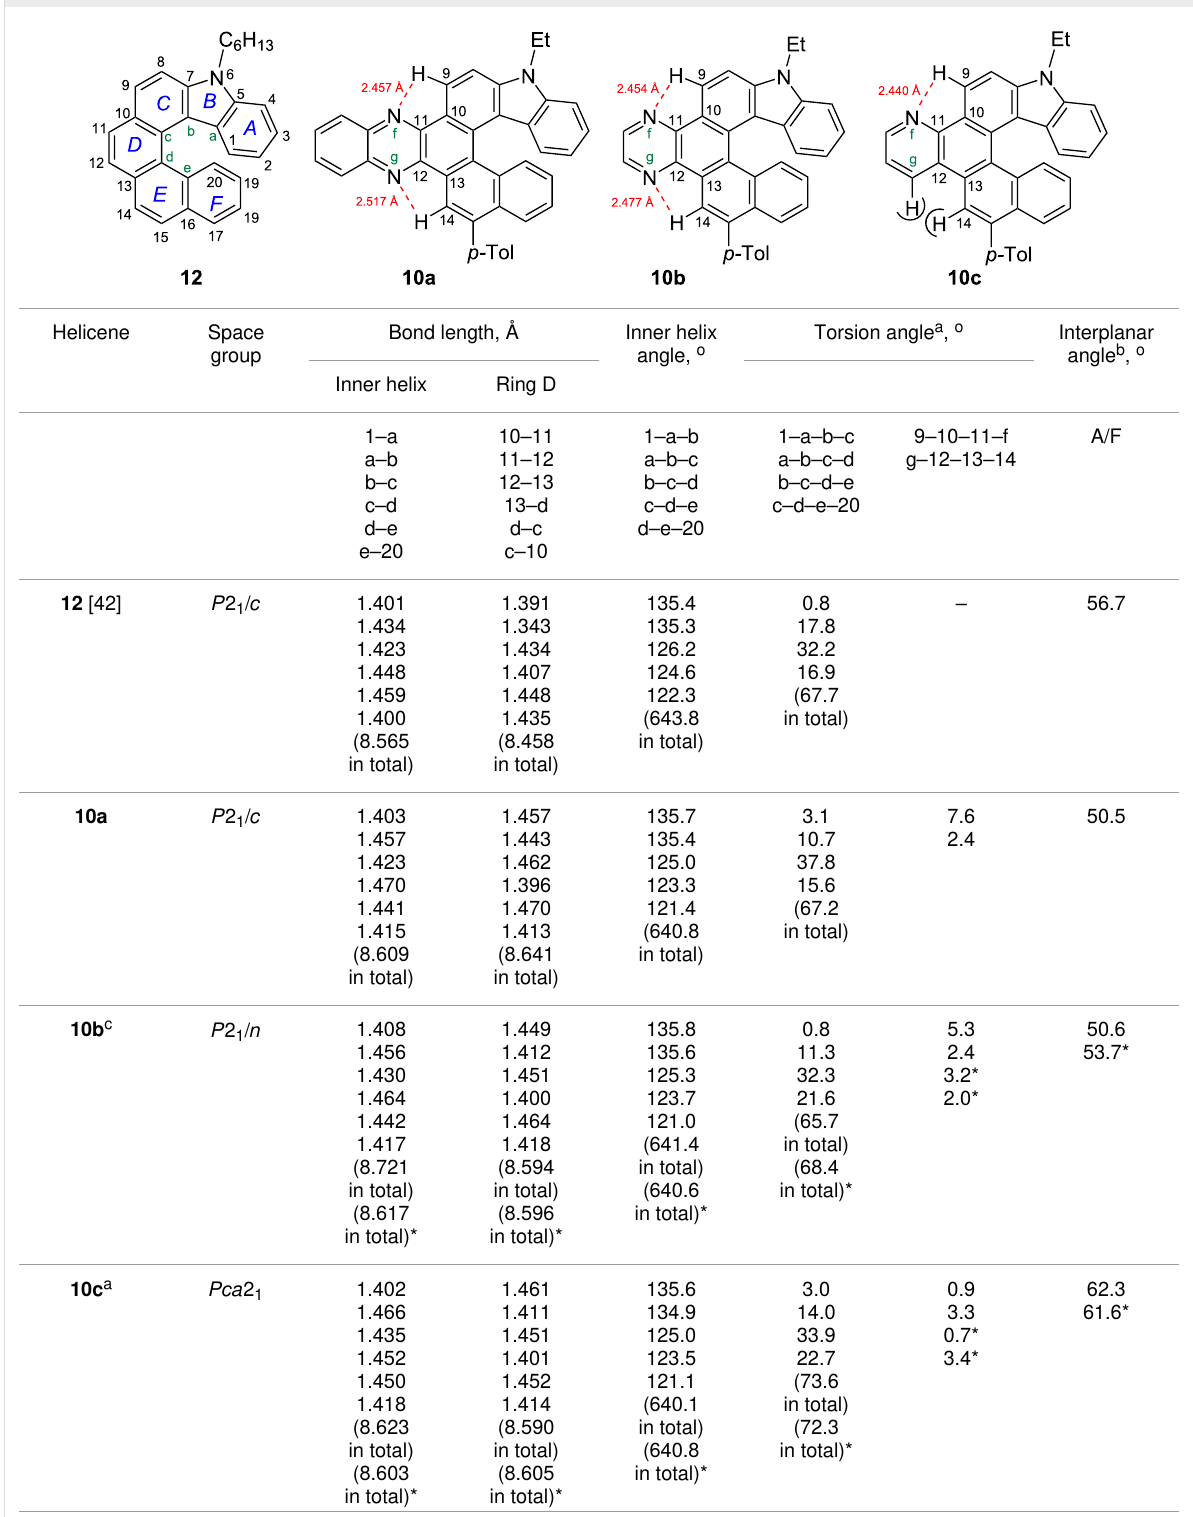
Table 6: Comparison of X-ray data of the carbazole-based [6]helicenes (atomic numbering does not correspond to IUPAC nomenclature).